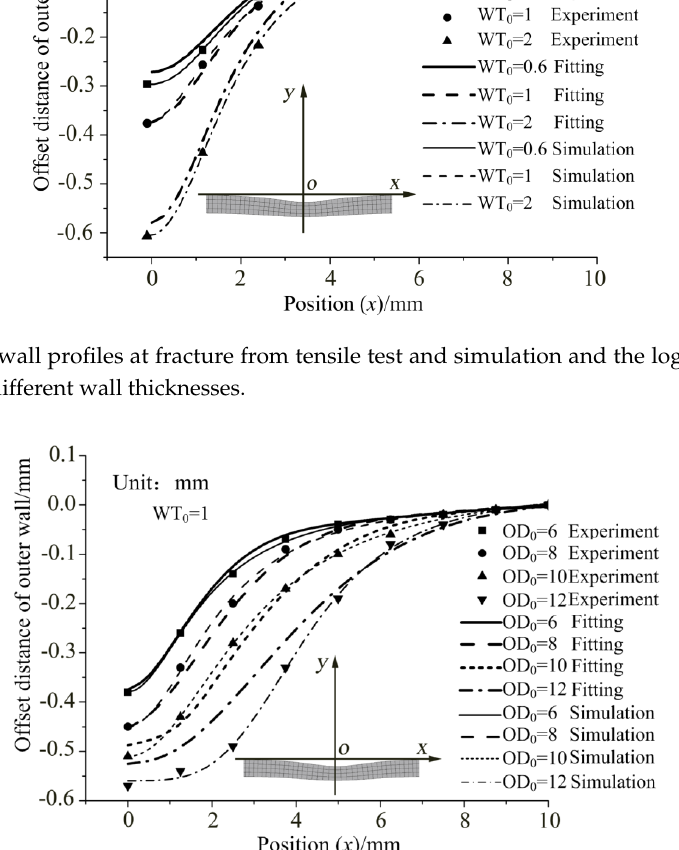
Table 3. Fitted parameters of the Logistic regression model for WT 0 = 1 mm tubes with different OD 0 . Outer Diameter (mm) Max Offset Distance of Outer Wall (mm) A (mm) x 0 (mm)